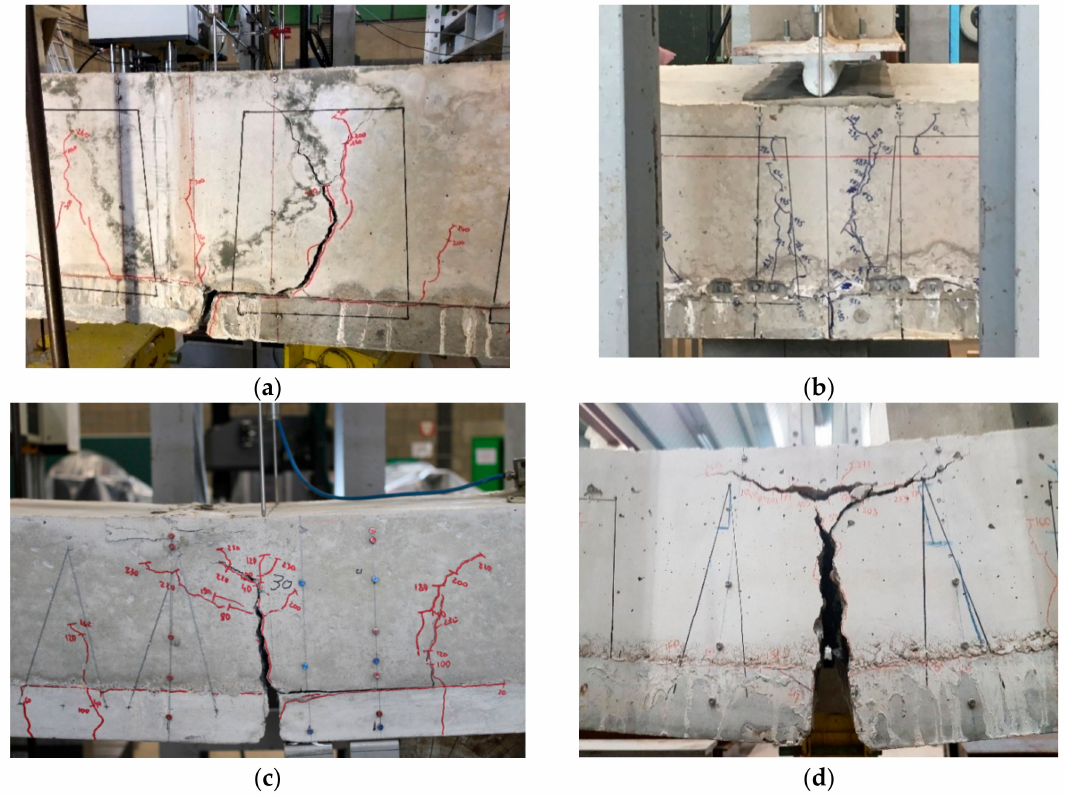
Figure 10. Crack pattern at the joint location for ( a ) A-series (A01); ( b ) B-series; ( c ) C-series (C04); ( d ) D-series (D01)